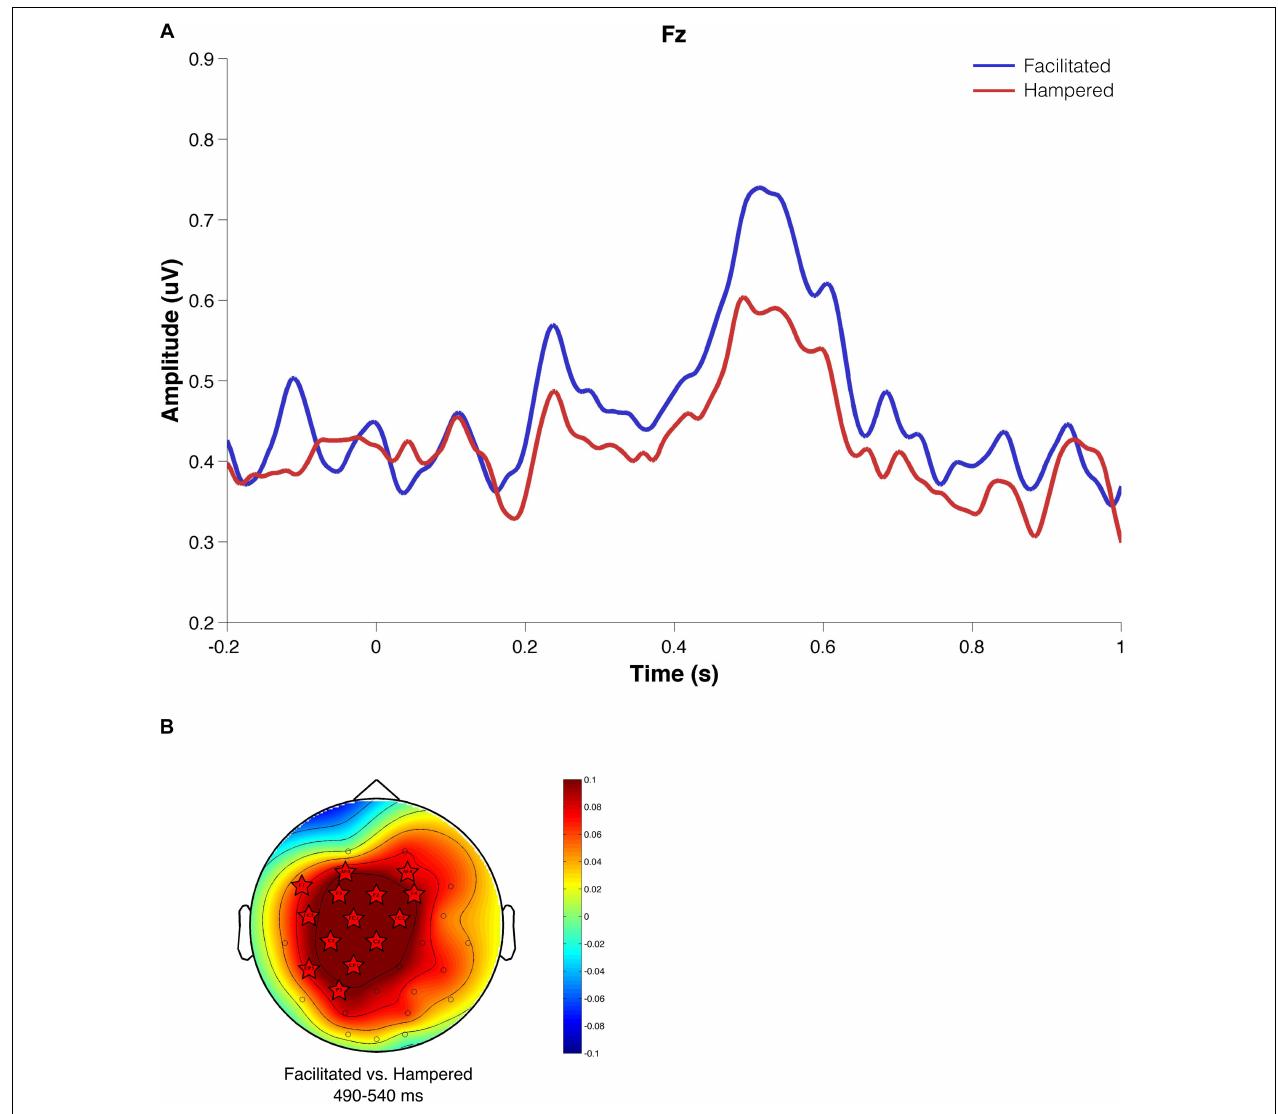
FIGURE 7 | Evoked brain activity based on subjective experience. (A) Evoked activity to the first shift signal. The facilitated condition is shown in blue and the hampered condition in red. (B) Scalp amplitude difference map for the P300 time window (490–540 ms). Stars show electrodes that present significant differences between conditions according to a non-parametric cluster-based permutation